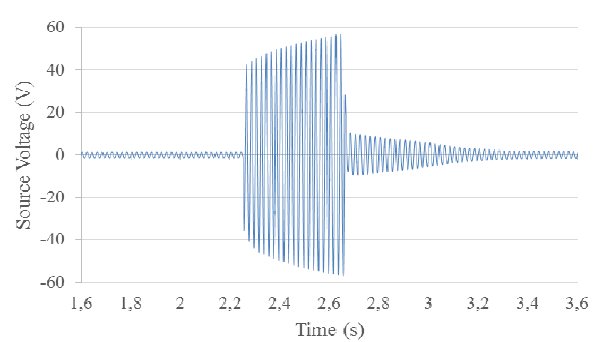
Fig. 9. Voltage drop over the terminals of the limiter for prospective currents of 80 A regarding configuration